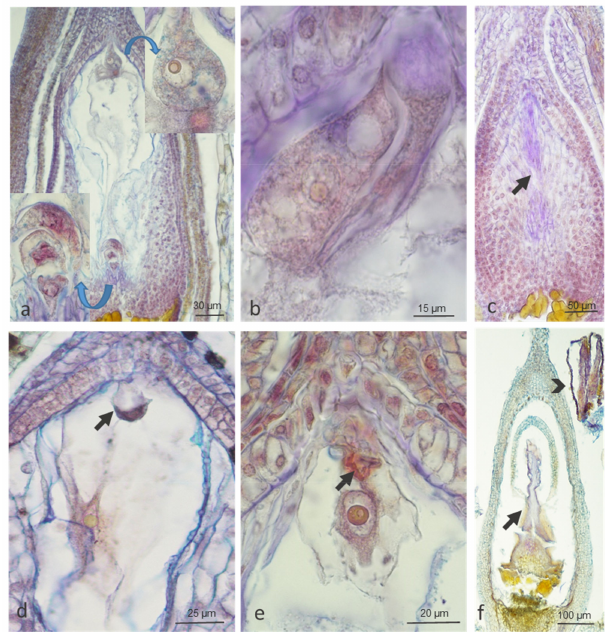
Figure 3. Abnormal female gametophyte development (megagametophytogenesis) at three stages of flower development in ‘Panda’ and PA15 genotypes of common buckwheat under control (20 ◦ C) and thermal stress (30 ◦ C) conditions. Abnormal vacuolization of egg cells of ‘Panda’ (upper insert in ( a )) and of PA15 open flowers at 30 ◦ C ( b ), at the chalazal pole three antipodal cells visible (lower insert in a ); degeneration of 2–4-nucleate embryo sac of ‘Panda’ bud at 20 ◦ C (arrow, c ), of egg cell in PA15 open flowers at 20 ◦ C (arrow, d ), and of egg apparatus (arrow, e ), ovule (arrow, f ), and stamens (arrowhead, f ) of ‘Panda’ open flowers at 30 ◦ C. Paraffin sections stained with Ehrlich’s hematoxylin combined with Alcian blue. The number of analyzed flowers per treatment at each stage of development was 15–32 in two